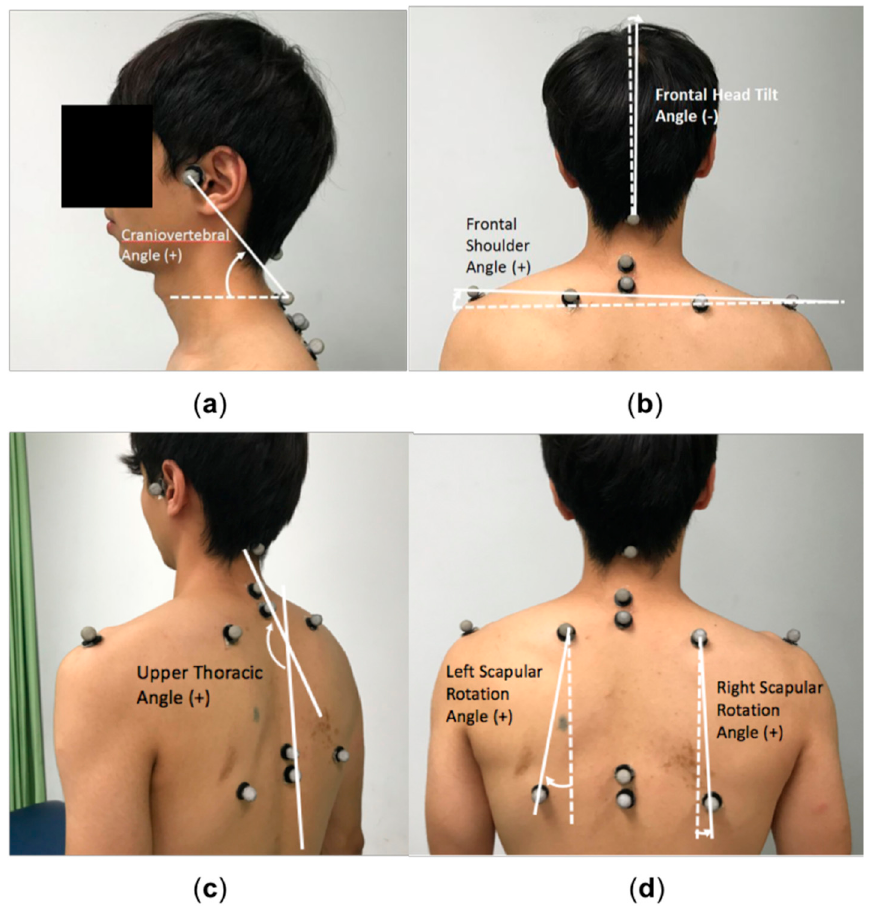
Figure 1. Marker placement and angle definition. ( a ) Craniovertebral angle was defined as the angle between the line connecting the tragus of the ear and the spinous process of the C7 and the horizontal line; ( b ) Frontal head tilt angle was defined as the angle between the midline of the head relative to the vertical line. Frontal shoulder angle was defined as the angle between the line connecting the left acromion and right acromion and the horizontal line; ( c ) Upper thoracic angle was defined as the angle between the line connecting the spinous processes of the T1 and T2 and the line connecting the spinous processes of the T6 and T7; ( d ) Scapular rotation angles were defined as the angle between the line connecting the superior and inferior scapular angles and the vertical line.